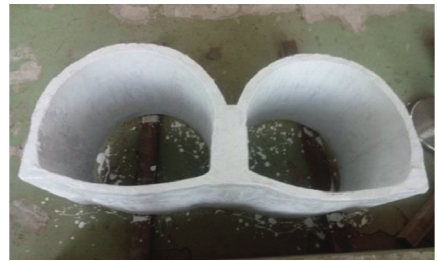
Figure 4: Lining model.